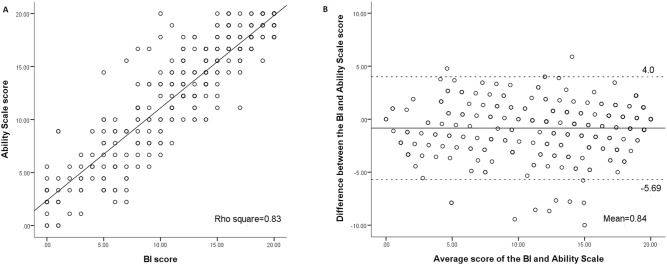
Correlation (A) and Bland-Altman plot (B) for the BI and Ability Scale.The Ability Scale scores were 0•20 transformed scores.